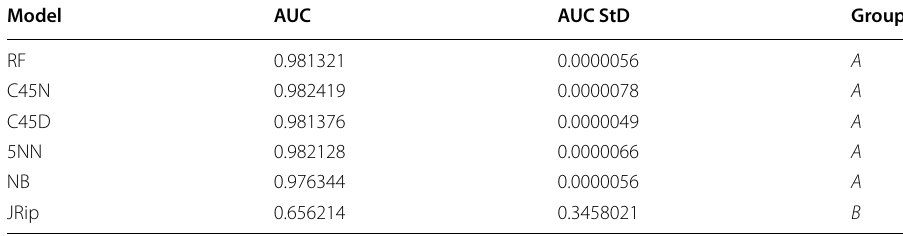
Table 6 Tukey’s HSD group initial results